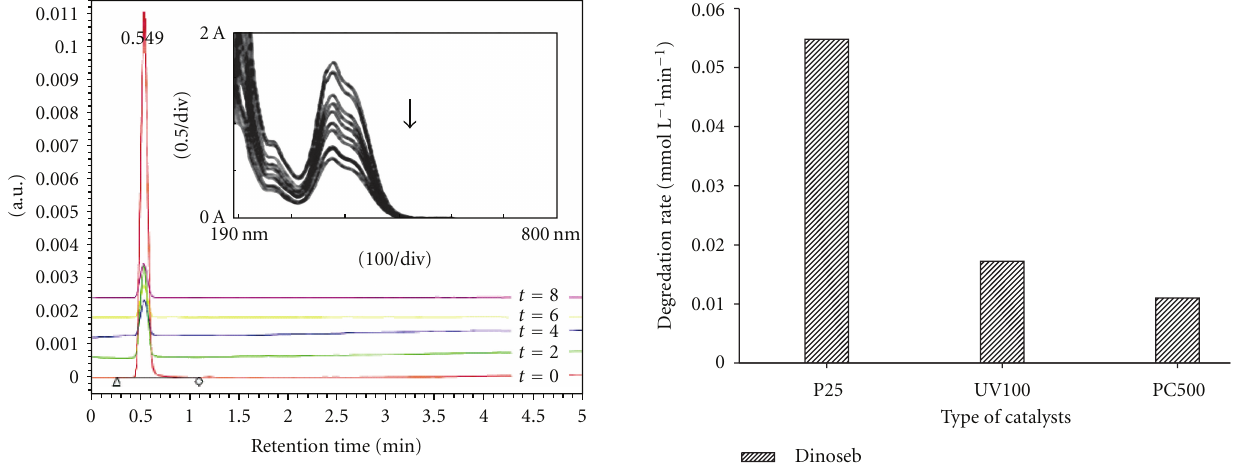
Figure 3: Comparison of degradation rate (change in absorption intensity versus irradiation time) of Dinoseb in the presence of di ff erent photocatalysts. Experimental conditions: photocatalysts: TiO 2 Degussa P25 (1gL − 1 ), Sachtleben Hombikat UV100 (1gL − 1 ), and PC500 (1gL − 1